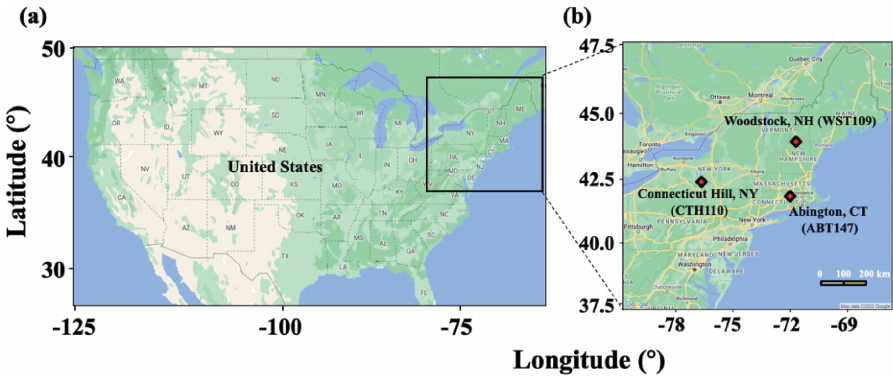
Figure 1. Map of the United States (a) and selected CASTNET sites (b) for this study in the northeastern US. Major cities (urban areas), transportation routes, and CASTNET sites are also indicated in (b) . The image was created using Google Earth (© 2023 Google).